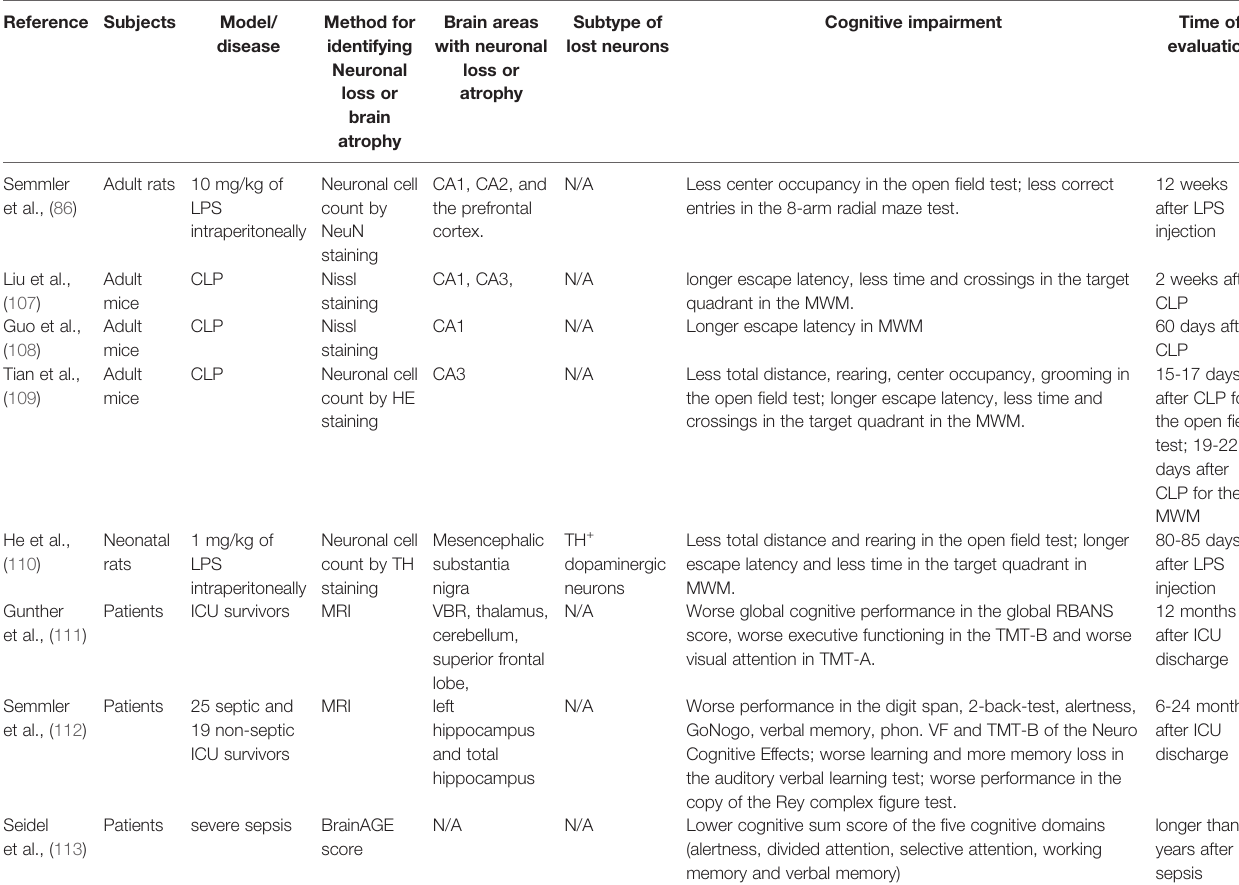
TABLE 1 | Representative studies of neuronal loss mechanism underlying long-term cognitive impairment after sepsis. Reference